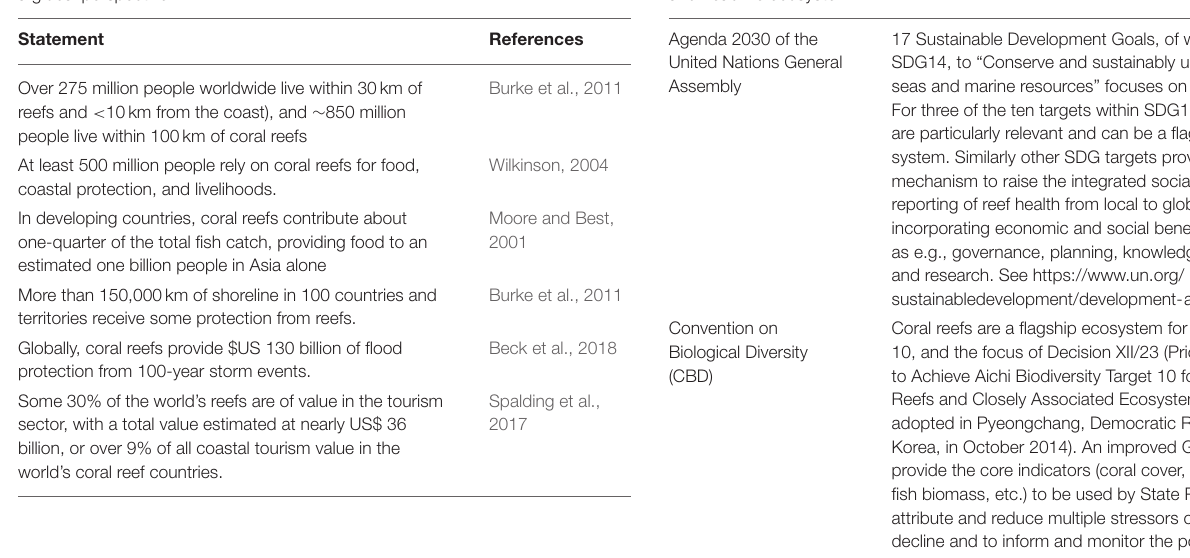
TABLE 2 | Global and regional instruments for which coral reefs are an important and headline